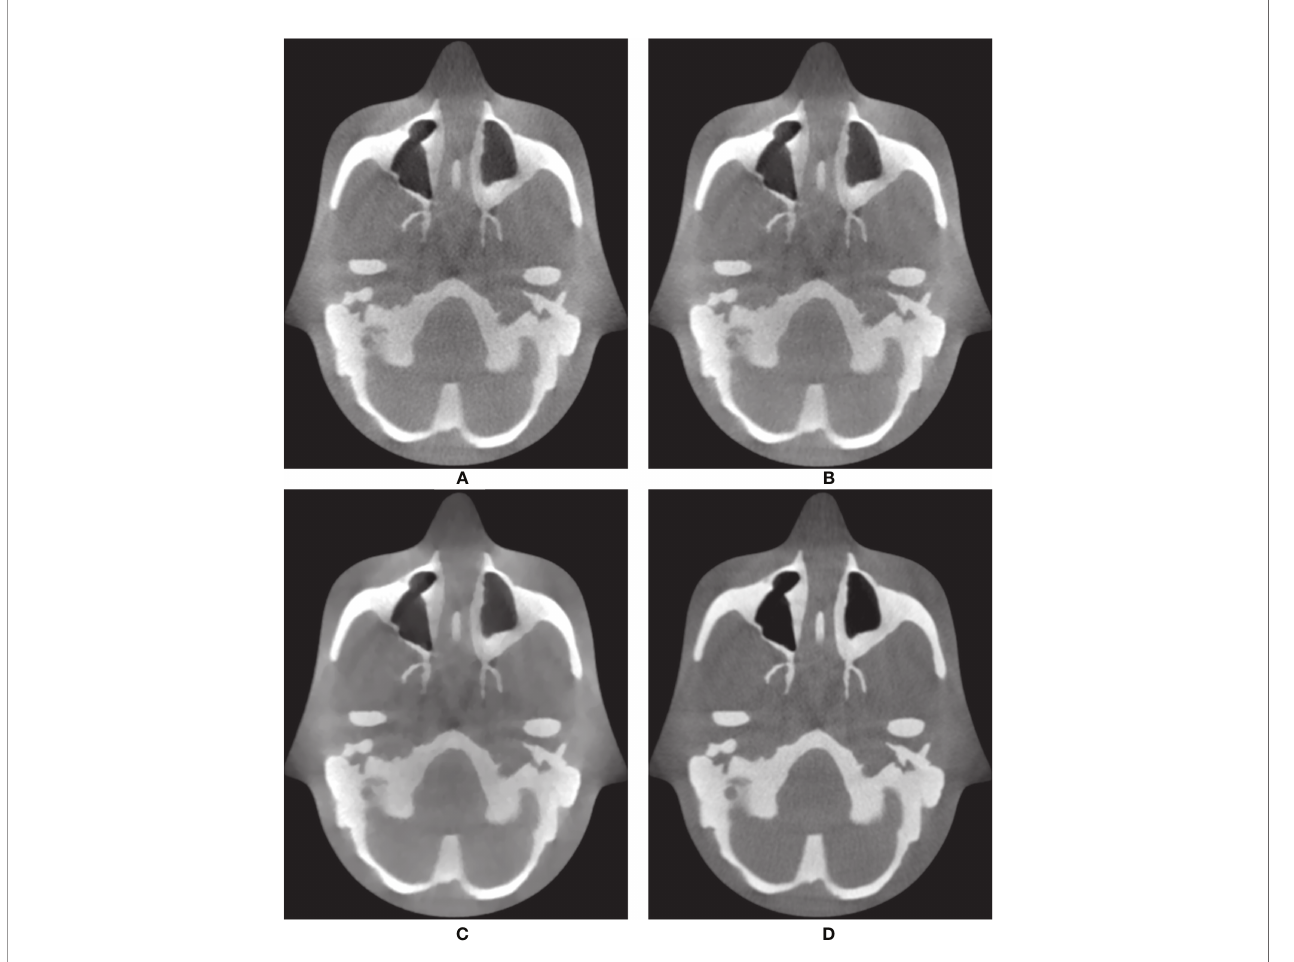
FIGURE 6 | Comparison between the same views of CBCT images generated by applying the analytical reconstruction algorithm based on (A) RDB, (B) RDB followed by NLTV, and (C) RDB followed by MI-NLTV using the anthropomorphic head-and-neck phantom. (D) Benchmark image. These CBCT images are displayed at the window settings of (width = 1,400, level = 200)